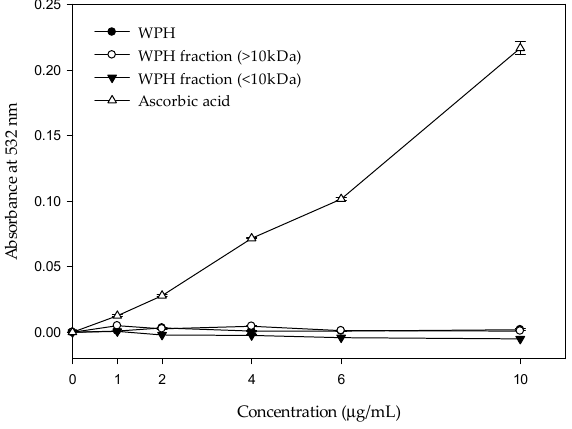
Figure 4. Effect of WPH and WPH fractions on DNA damage induced by bleomycin–Fe 3+ .